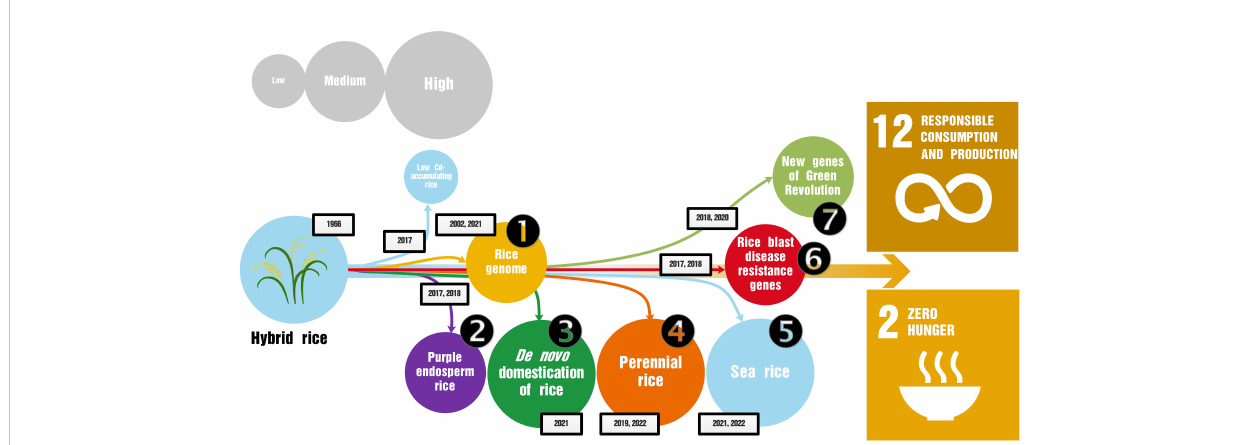
FIGURE 1 Evolution of the shifting rice research themes that were originally derived from hybrid rice. In addition to hybrid rice, low cadmium-accumulating rice and sea rice were mainly developed by Yuan Longping and his team (indicated by blue circles and lines). The remaining six research areas carried out by Chinese rice scientists are shown in the order discussed in this article (circled hollow numbers); numbers in the boxes outlined in black indicate the breakthrough year for each area of research, but not the year when the research was initiated. The importance of these research studies to the achievement of the Sustainable Development Goals is represented by the size of the circle, which is arbitrary. According to the nature of the research and the inherent relevance to the Sustainable Development Goals, these research areas are divided into different groups; for example, sea rice, de novo domestication of rice, perennial rice, and purple endosperm rice are conducive to the realization of Goal 2; low cadmium-accumulating rice and research on new Green Revolution varieties of rice are conducive to the realization of Goal 12; whereas research on the rice genome and rice blast disease promote the realization of both goals